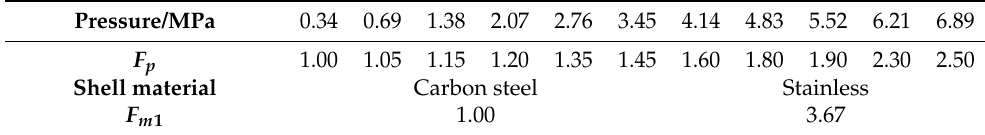
Table A1. Correction factors for reactor and distillation column.